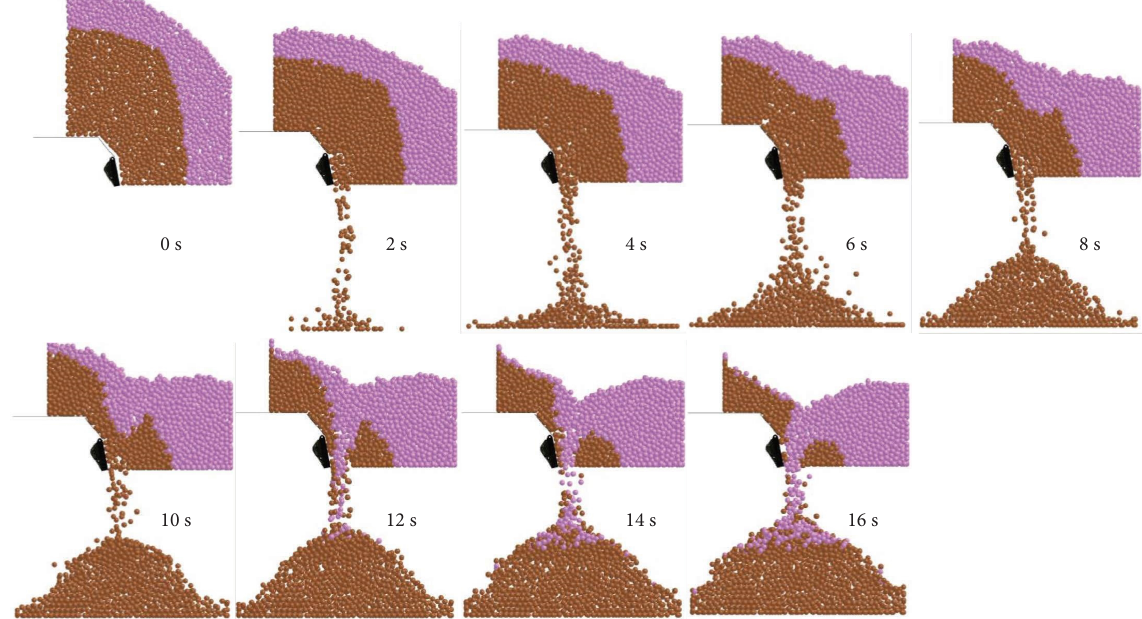
Figure 20: Te evolution of the coal-caving process at 4m